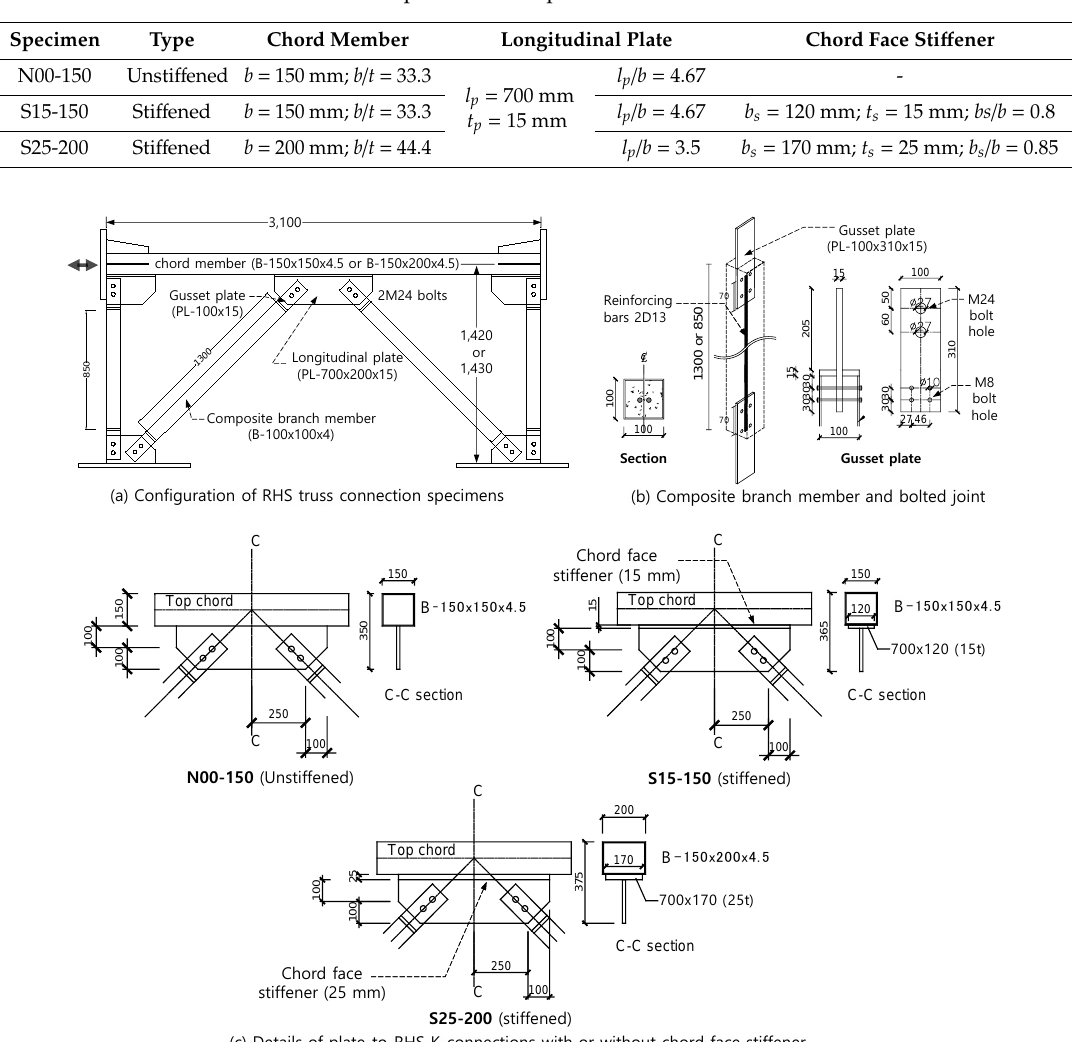
Table 3. Geometric parameters of plate-to-RHS truss connections.